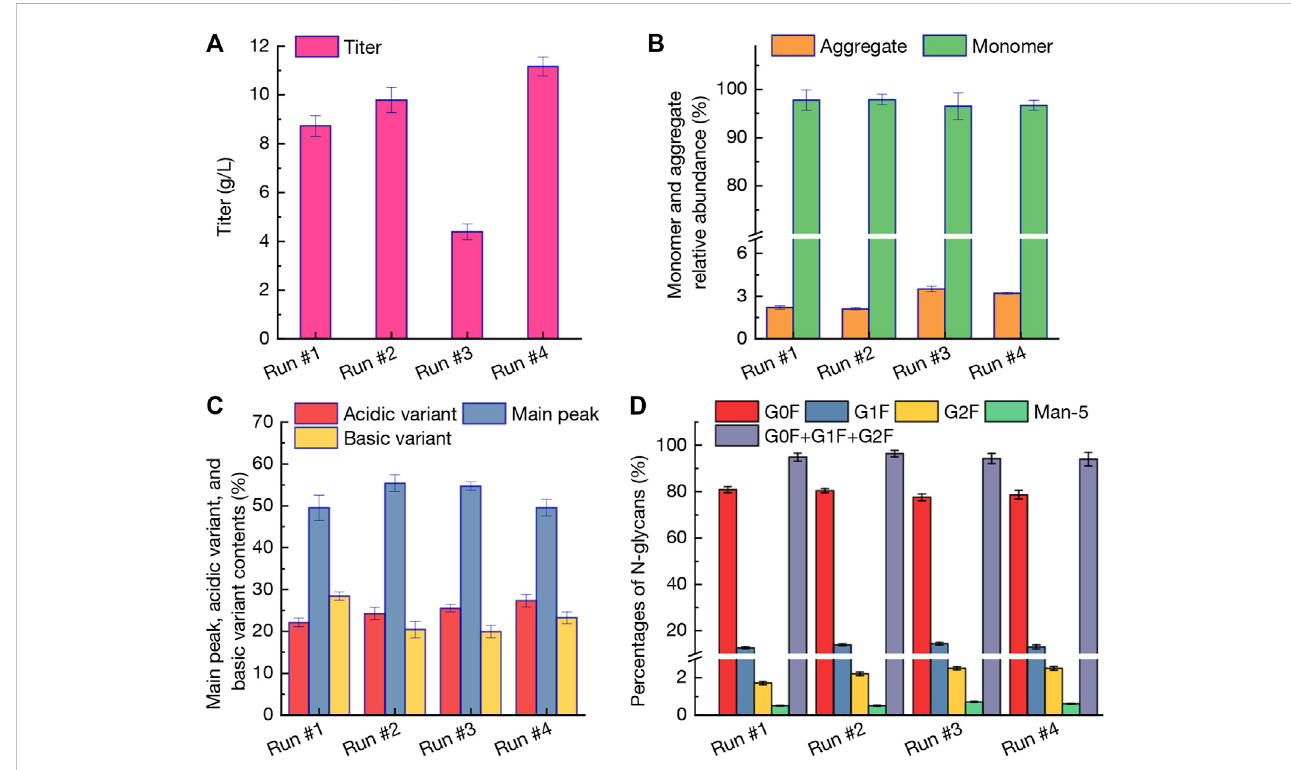
Pro fi lesofmAbtiter (A) ,monomerandaggregaterelativeabundance (B) ,variantcontents (C) ,andpercentagesofN-glycans (D) underperfusioncultures of run #1-#4. The error bars indicate the SD of three independent